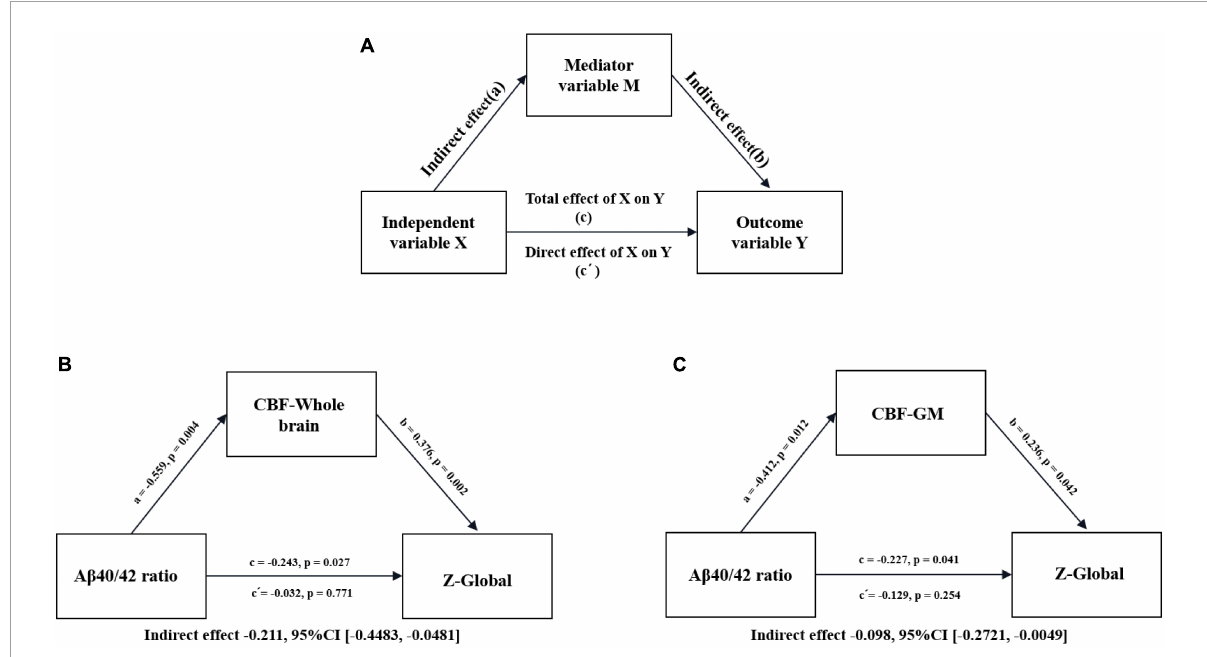
FIGURE6 Conceptual diagram of mediation analysis between A β 40/42 ratio, CBF, and global cognition in patients with SIVD-MCI. (A) Conceptual diagram of a mediation analysis model with one mediator. Total effect of X on Y (c) = indirect effect of X on Y through M (a × b) + direct effect of X on Y (c’). (B) Serum A β 40/42 ratio (X), CBF in the whole brain (M), z -score of global (Y). (C) Serum A β 40/42 ratio (X), CBF in the GM (M), z -score of global (Y). Path coefficients with P -values. GM, gray matter; CBF, cerebral blood flow; CI, confidence